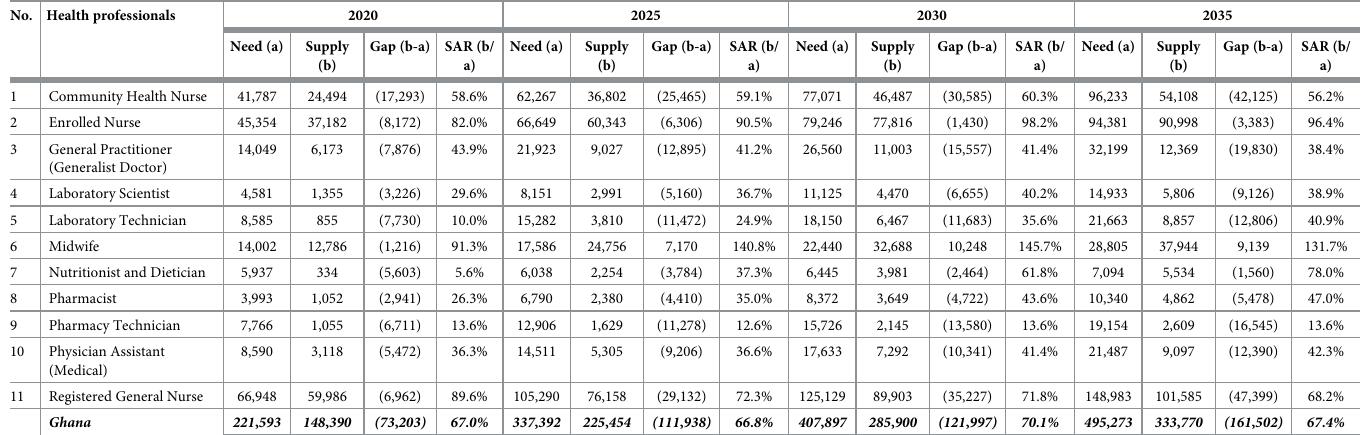
Table 4. Supply versus need-based gaps,